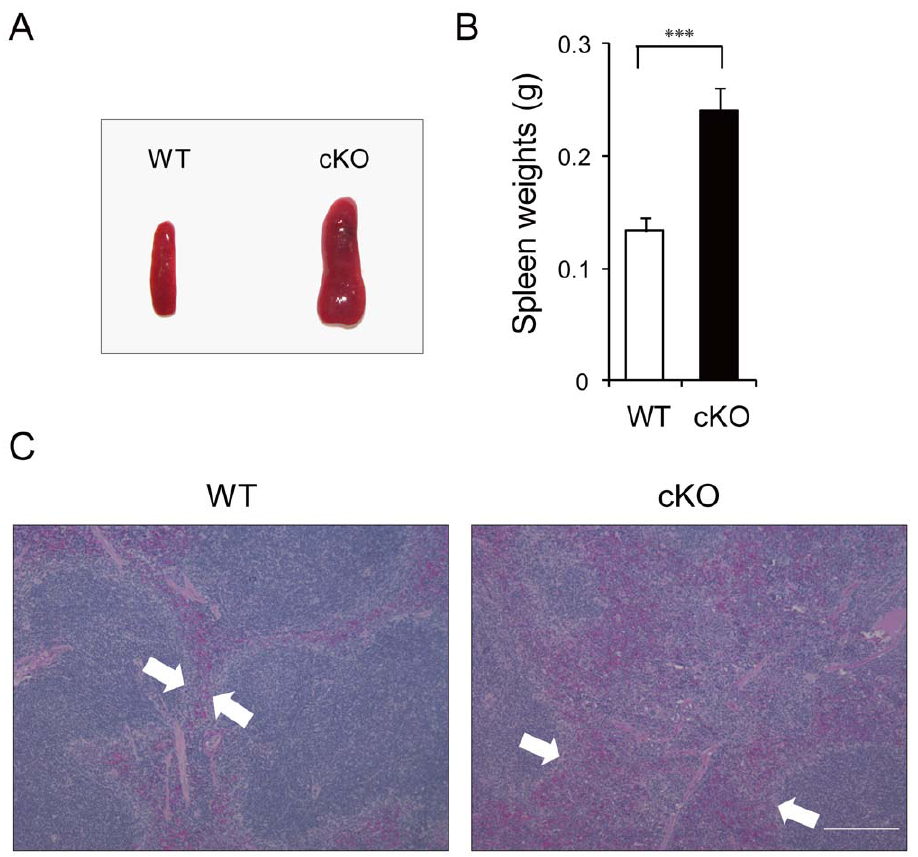
Figure 5. Increase extramedullary hematopoiesis in the spleen of Grp94 KO mice. A) Representative spleen size and morphology of WT and cKO mice. B) Average spleen weights of WT (n=19) and cKO (n=25) mice. The data are presented as mean 6 s.e., ***p , 0.001. C) Representative H&E staining of paraffin sections of spleen from WT and cKO mice. Hematopoietic cells in the red pulp are indicated by the area between the two arrows. Scale bar represents 2 mm.